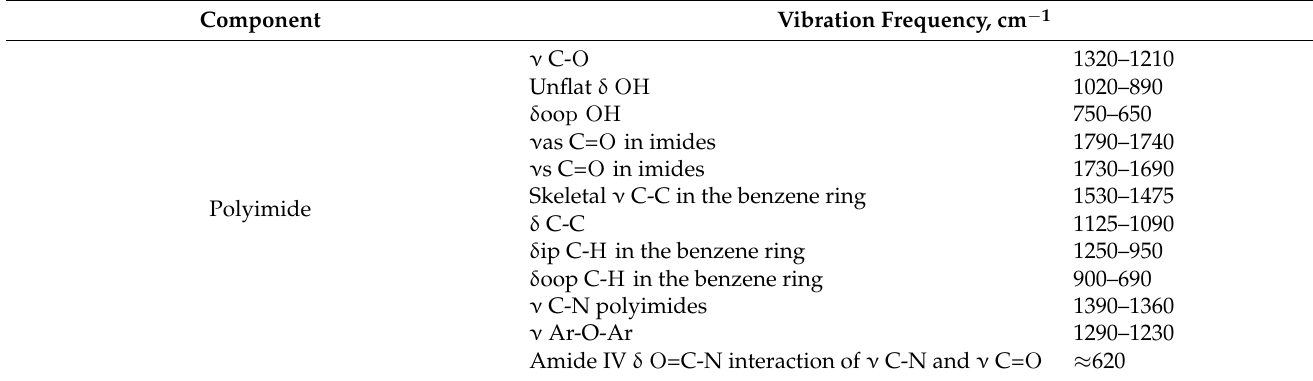
Table 1. Interpretation of IR spectra of track polyimide membranes treated with products of acidic and alkaline catalysts hydrolysis of